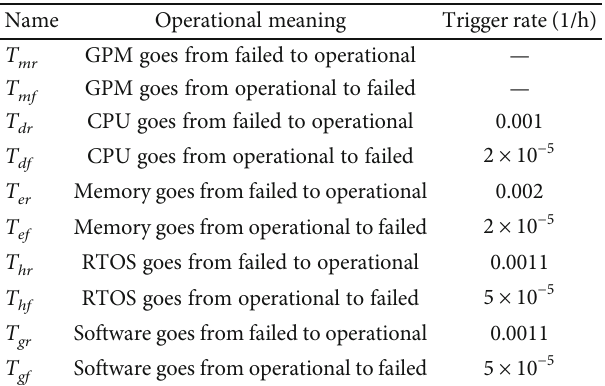
Figure 6: The GSPN model of GPM. Table 2: Transitions in GSPN model for